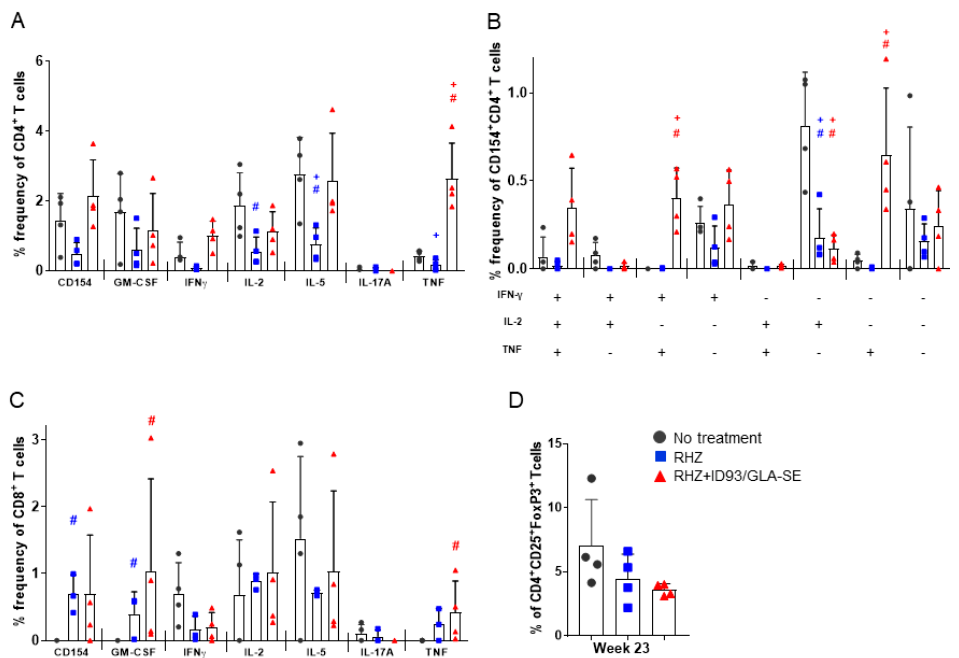
Figure 6 . Increased ID93-specific cytokine responses from CD4 + and CD8 + T cells in the lung following immunotherapy. Pulmonary T cell responses assessed 23 weeks after Mtb infection. ( A ) The percent of single-cytokine producing CD4 + T cells; ( B ) the percent of polyfunctional CD4+ T cells producing one or more cytokines; and ( C ) the percent of single-cytokine producing CD8 + T cells, examined by intracellular flow cytometry after ex vivo stimulation with ID93 antigen. Data are representative of